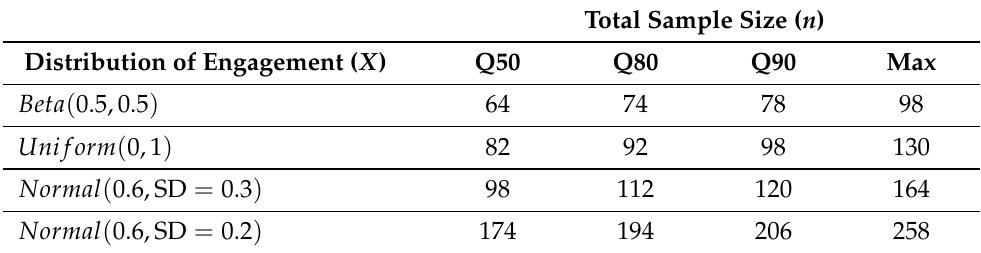
Table 1. Summary statistics for the total sample size distributions (cf. Figure 3). Total Sample Size ( n ) Distribution of Engagement ( X ) Q50 Q80 Q90 Max Beta ( 0.5, 0.5 ) 64 74 78 98 Uni f orm ( 0, 1 ) 82 92 98 130 Normal ( 0.6, SD = 0.3 ) 98 112 120 164 Normal ( 0.6, SD = 0.2 ) 174 194 206